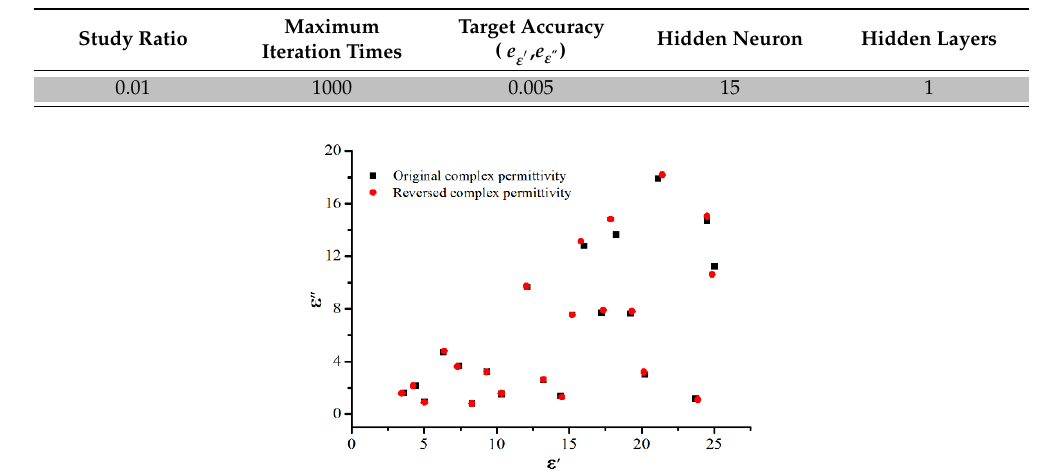
Table 1. Parameters used to train the artificial neural networks (ANN).